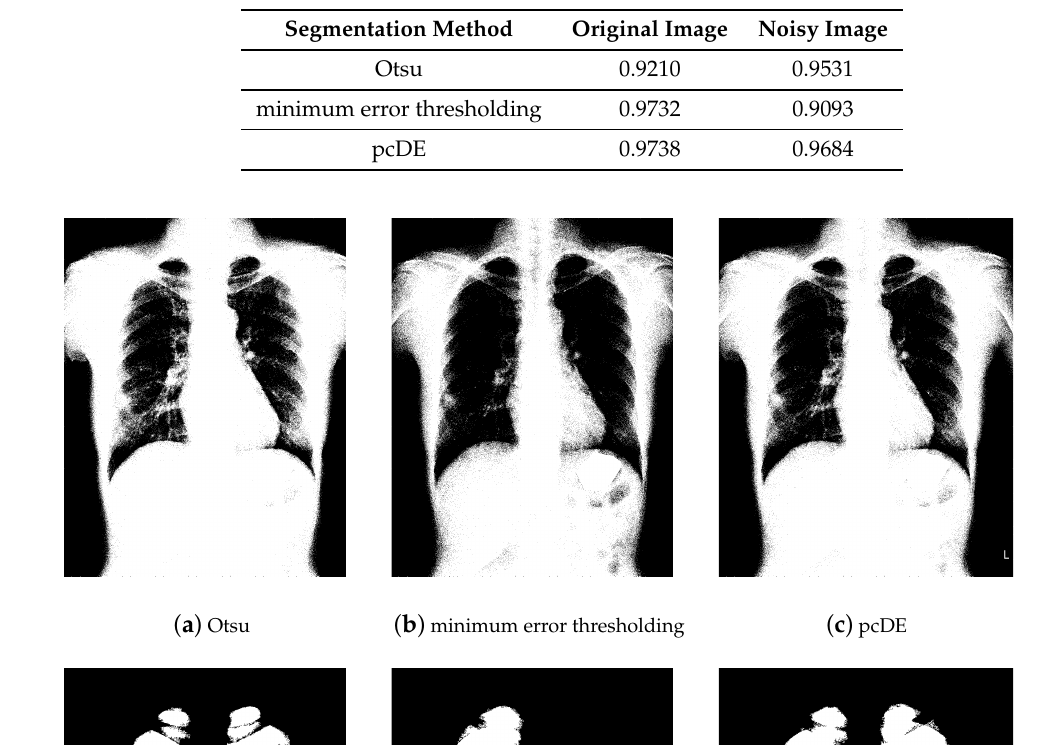
Table 5. DICE values obtained by different image segmentation methods.